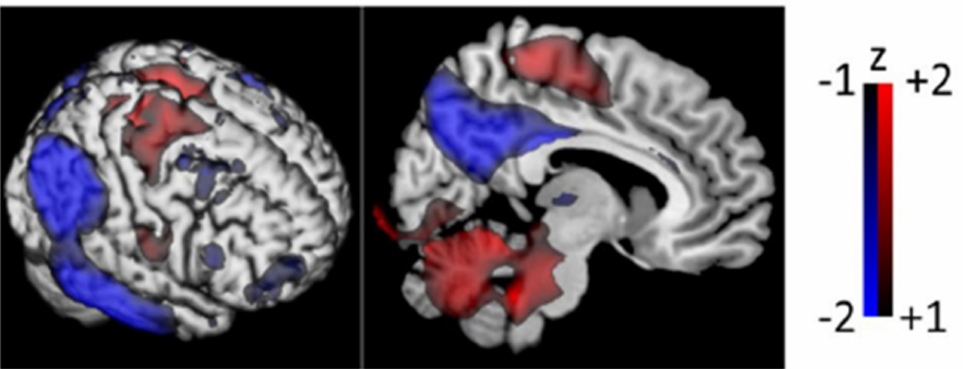
Figure 3. Performing PCA on FDG-PET images reveals disease-specific patterns in AD com- pared to healthy controls. PCs were obtained and eight of the first 10 were combined via step- wise linear regression to obtain the visualization seen above. Figure shows outer exterior ( left ) and medial exterior ( right ) surfaces. Images scaled according to mean z-score and standard deviation of whole images for the purposes of visualization. Reprinted/adapted with